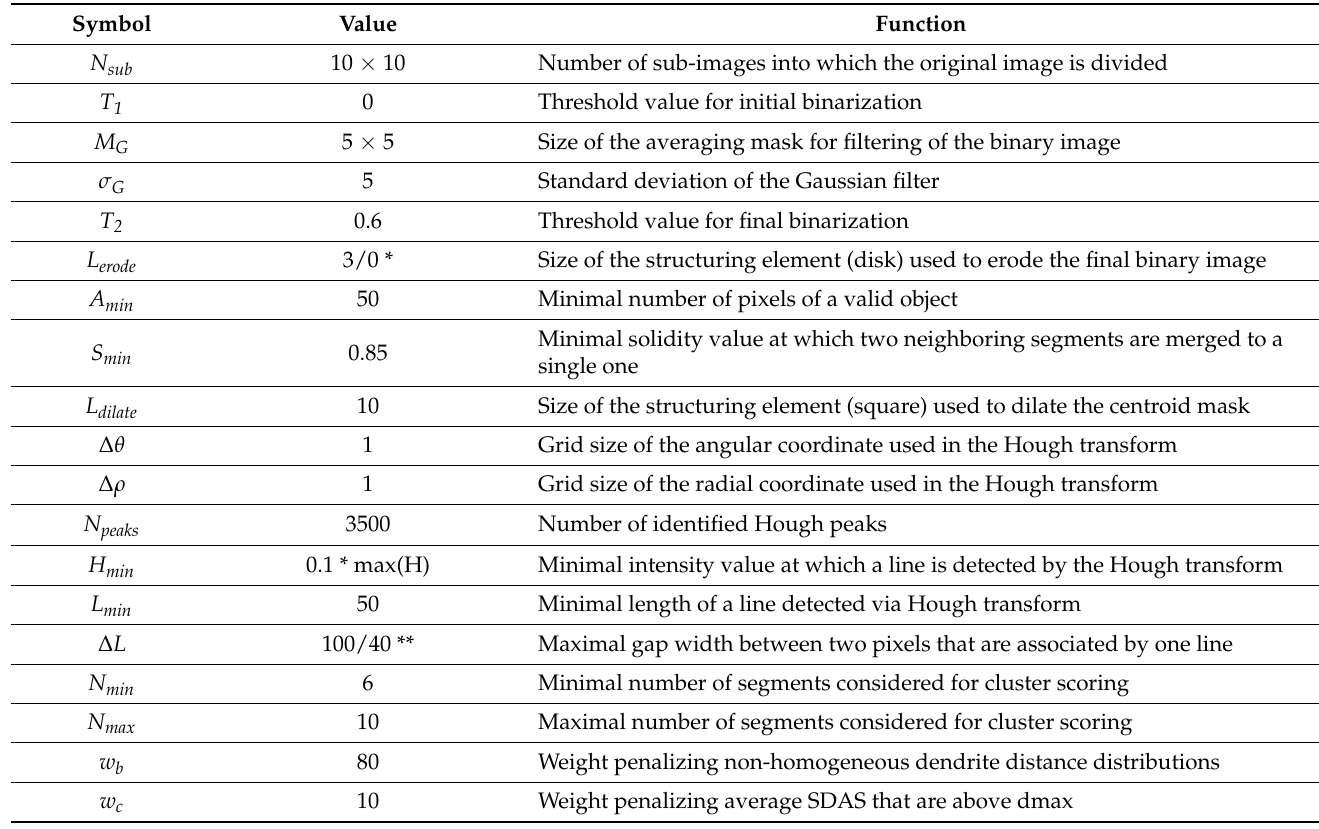
Table 1. Parameter values that are employed within the individual processing steps of the algorithms. Symbol Value Function N sub 10 × 10 Number of sub-images into which the original image is divided